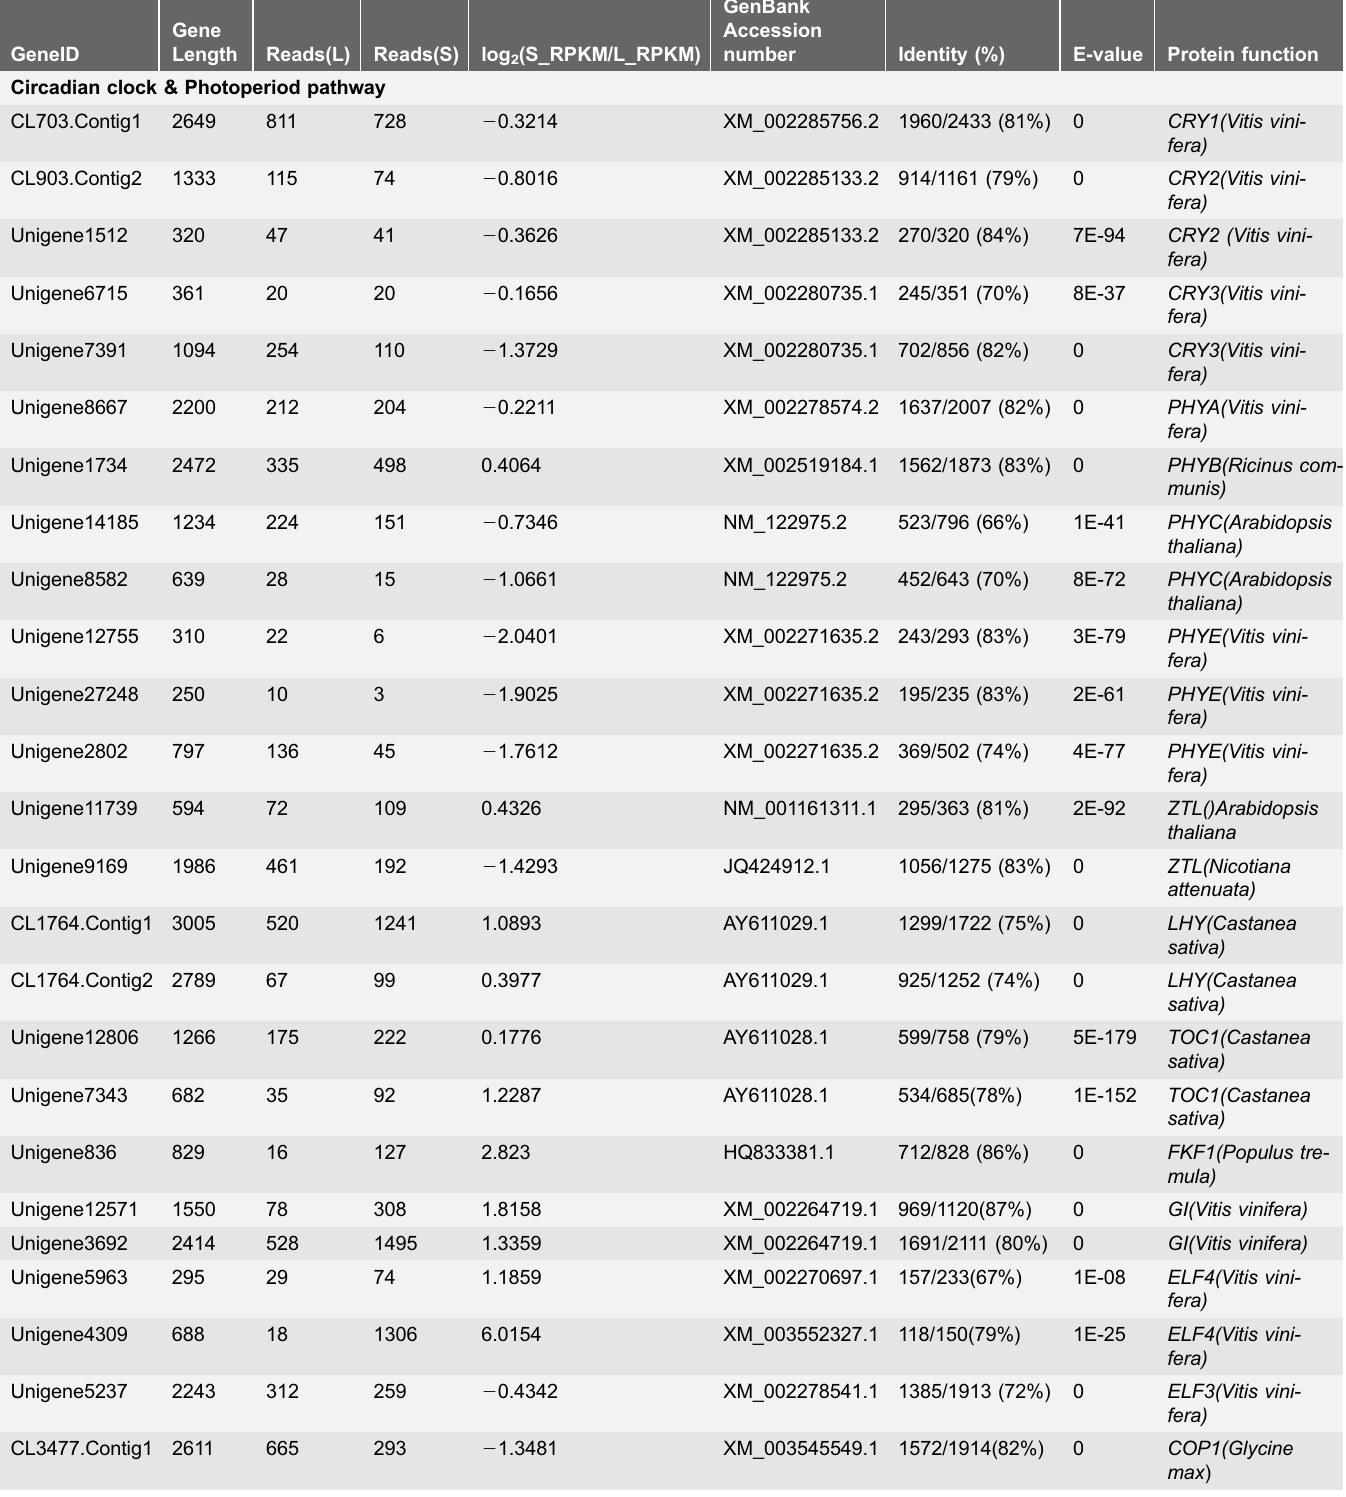
Table 3. Longan unigenes that share homology to flowering-time genes of other plants.